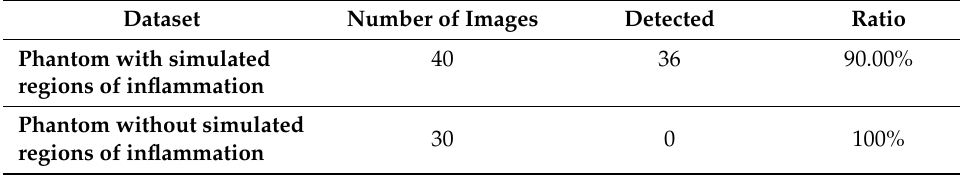
Table 2. Testing of inflammation detection algorithm with